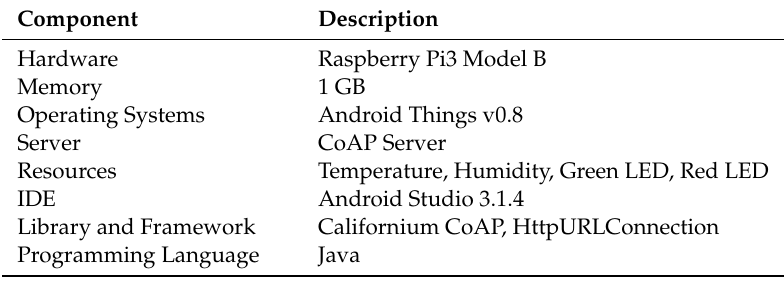
Table 2. Development environment for the Raspberry-based IoT device